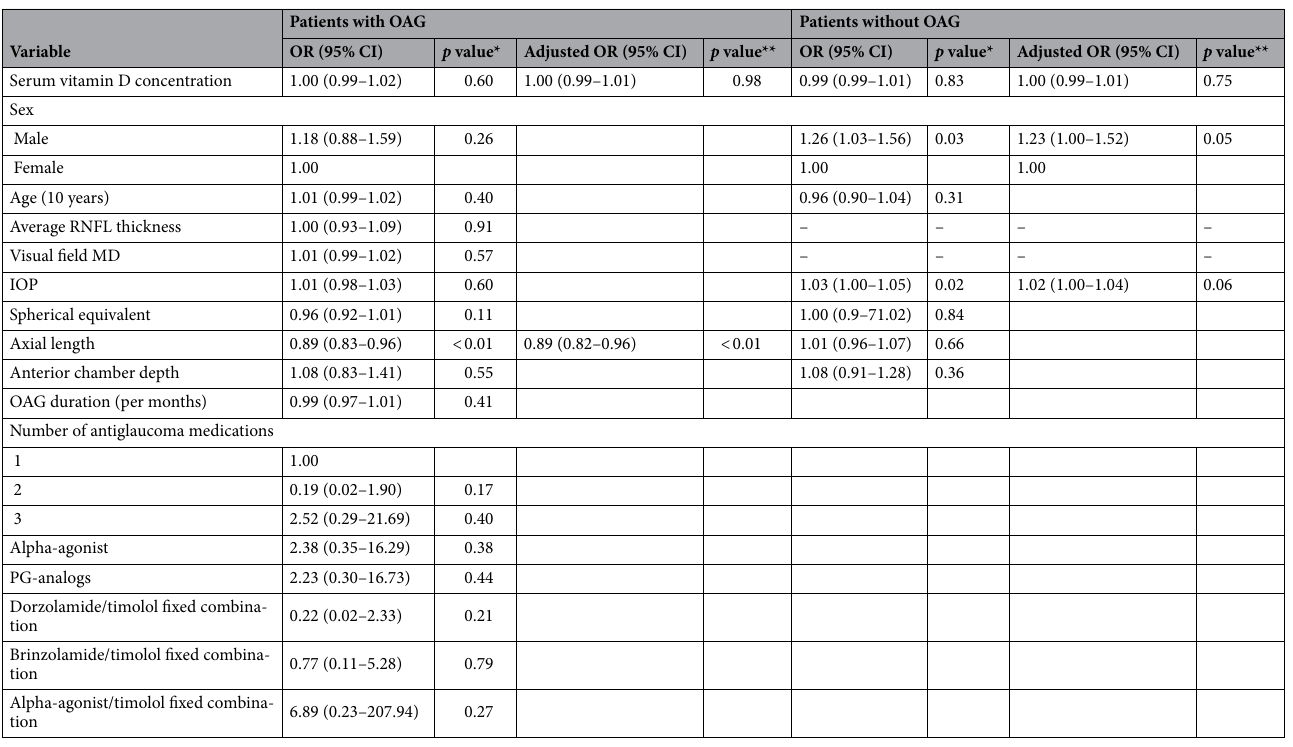
Table 3. Multivariate linear regression analysis of factors associated with 25(OH)D concentrations in aqueous humor in patients with OAG and without OAG. OAG open-angle glaucoma, RNFL retinal nerve fiber